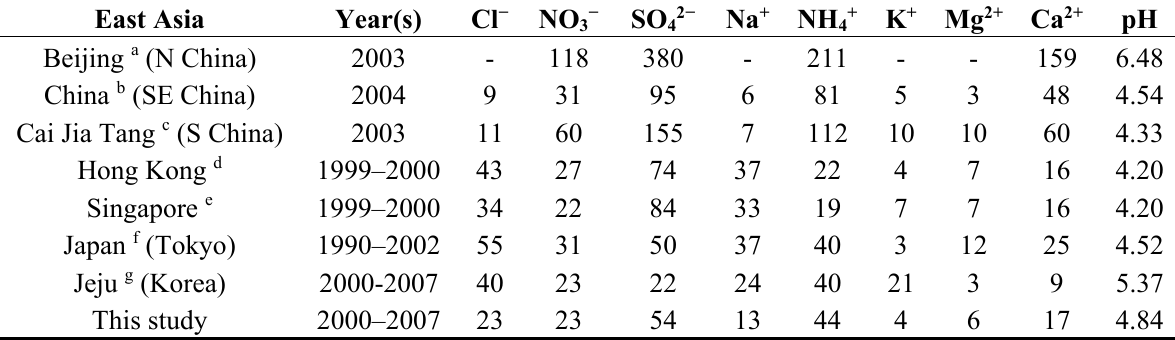
Figure 6. Annual variations of major inorganic VWM concentrations in the precipitation. Table 3. Volume-weighted mean (VWM) concentrations of the chemical components in wet-only precipitation in East Asia (µeq·L − 1 except